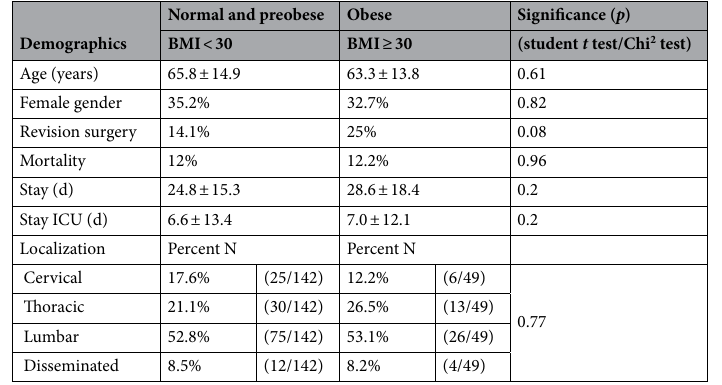
Table 2. Demographics. There is no statistical significance concerning revision surgery, mortality, hospital stay, ICU stay, or affected location but obese patients need to be surgically revised more often than normal weight patients.